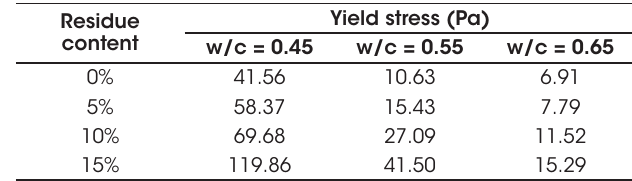
Yied stress values from flow